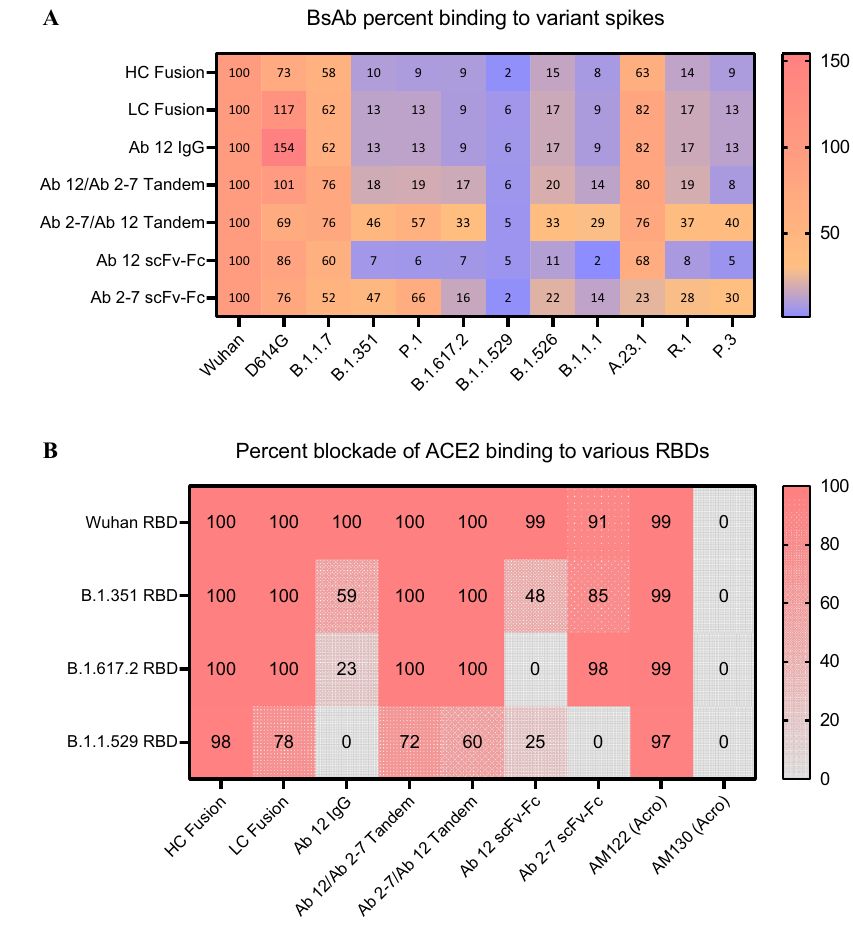
Fig. 6 | BLI binding and competition analysis for mono- and bispeci fi c con- structs with various variant spike/RBD proteins. A AHC sensors were loaded with anti-SARS-CoV-2 mono- and bispeci fi c Abs and then dipped into wells con- taining different Spike variants. Amplitude of the binding signal for each variant was normalized to that Ab format ’ s binding of the Wuhan spike. Though the par- ental Abs, IgG fusions, and Ab 12/Ab 2-7 tandem BsAbs exhibit marginal af fi nity to thevariantstested,Ab2-7/Ab12constantlybindsatagreaterlevelthaneitherofthe parentalAbs,indicatingasynergisticbindingpattern. B CompetitionwithACE2for